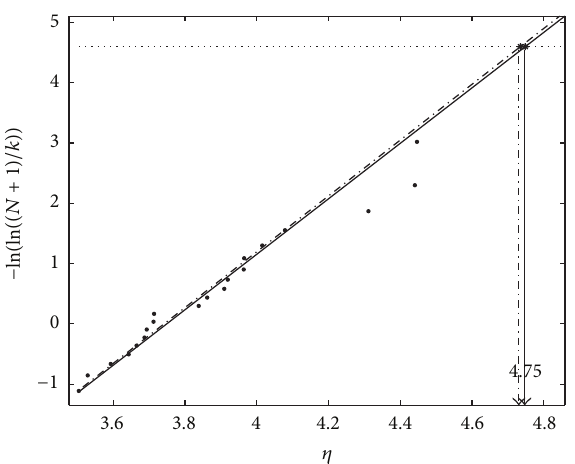
Figure 3: The point estimate ̃𝜂 100 yr of the 100-year return period value based on 20 years synthetic data. Lines are fitted by the method of moments—solid line (—) and the Gumbel-Lieblein BLUE method—dash-dotted lite (- ⋅ -). The return level estimate by the method of moments is 4.75, by the Gumbel-Lieblein BLUE method is 4.73.